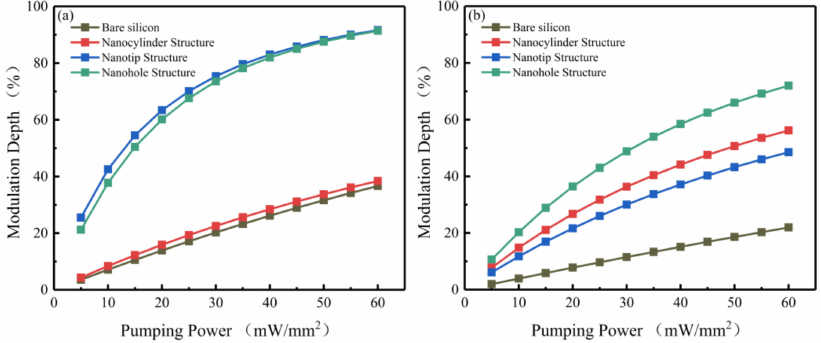
Figure 6. The modulation depths of bare silicon, nanocylinder, nanotip, and nanohole structures at 2 THz with 808 ( a ) and 532 nm ( b ) pump beams as a function of the pumping